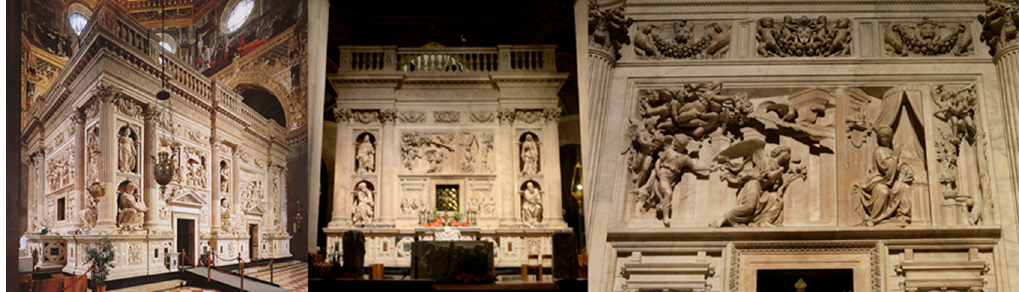
Figure 1. Photographic snapshots of (left to right) the Holy House, the west face of the Holy House, the sculpted panel of the